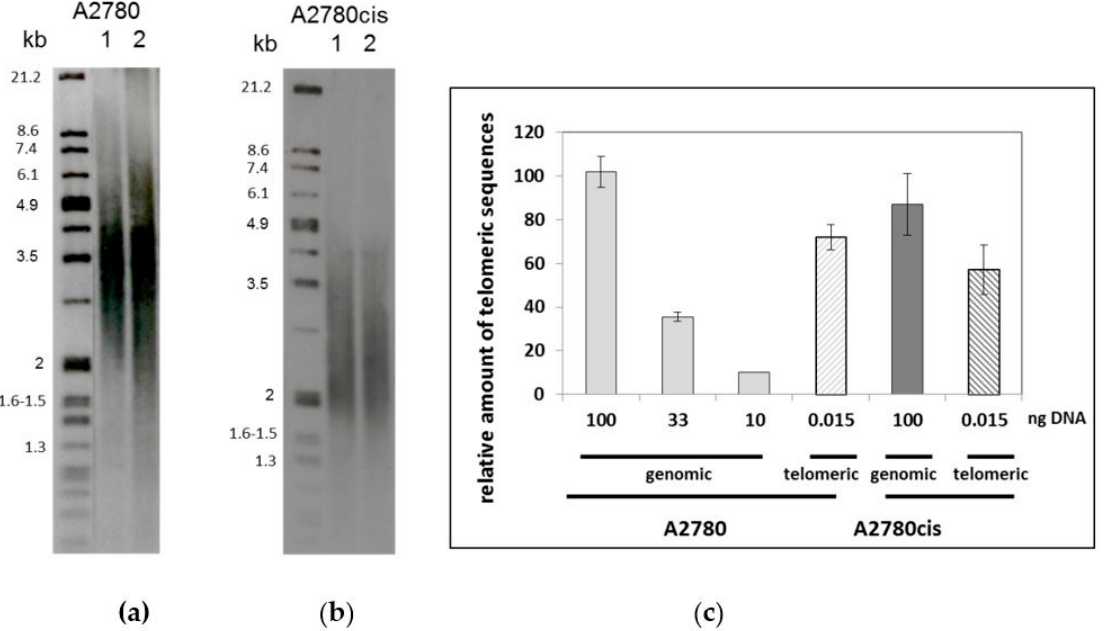
Figure 2. Telomere purification assay . Digested genomic DNA (4 µg) (lane 1) and isolated telomeres (2 ng) (lane 2) from A2780 cells ( a ) and A2780cis cells ( b ) were electrophoresed on a 0.6% agarose gel. Telomere restriction fragments were visualized using a luminescent telomeric probe. Size markers are shown on the left of each figure. ( c ) Relative enrichment in telomeres in the telomere purified fraction measured by qPCR compared to a range of non-digested genomic DNA.